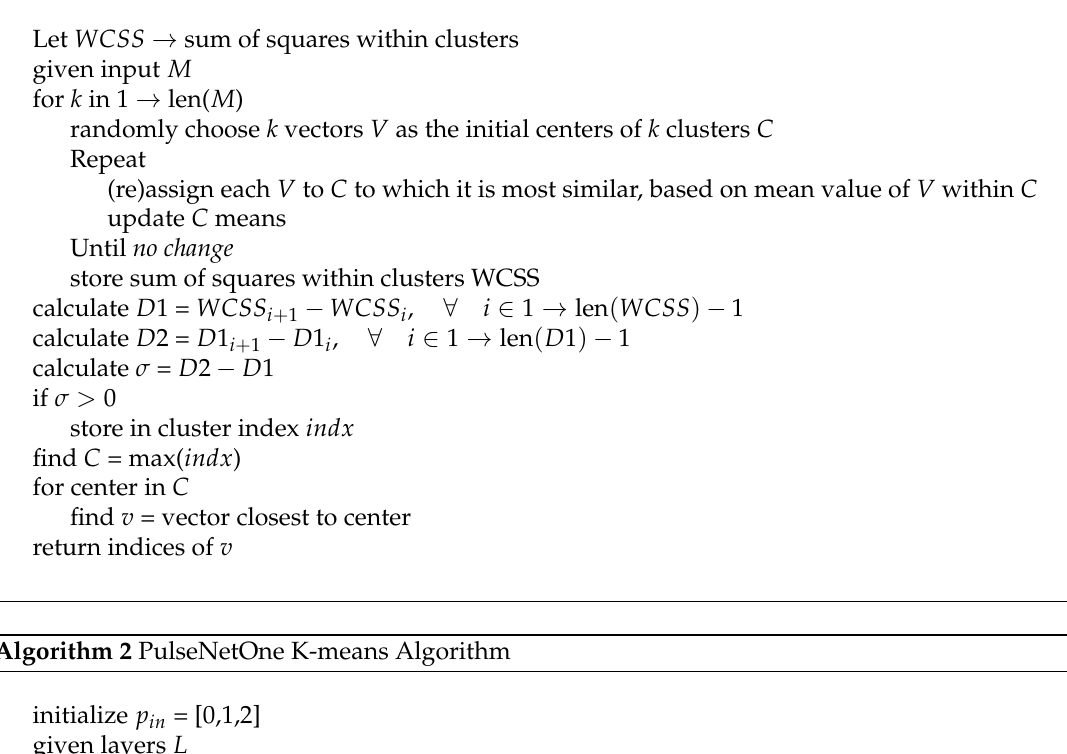
Algorithm 1 Get optimal k clusters